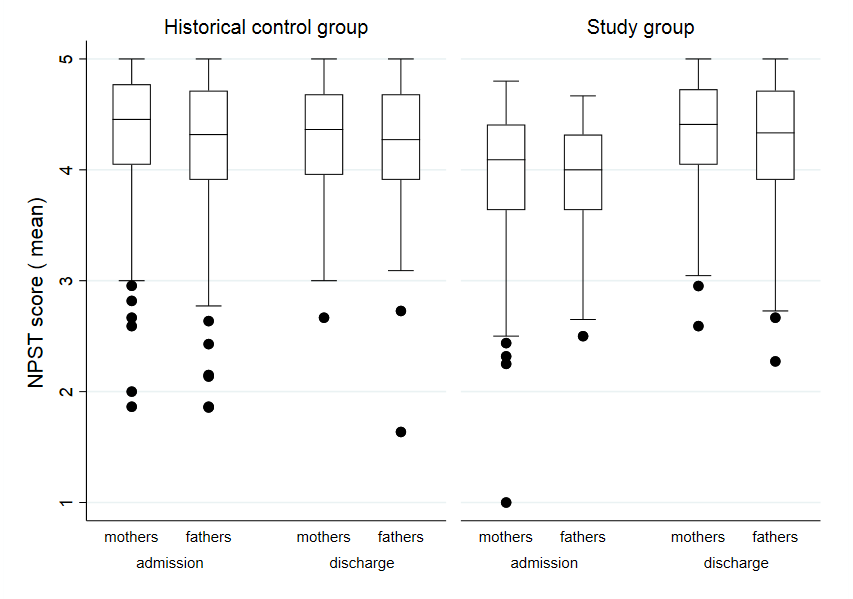
Figure 2. Boxplot of mean NPST score for mothers and fathers before and after the father- friendly